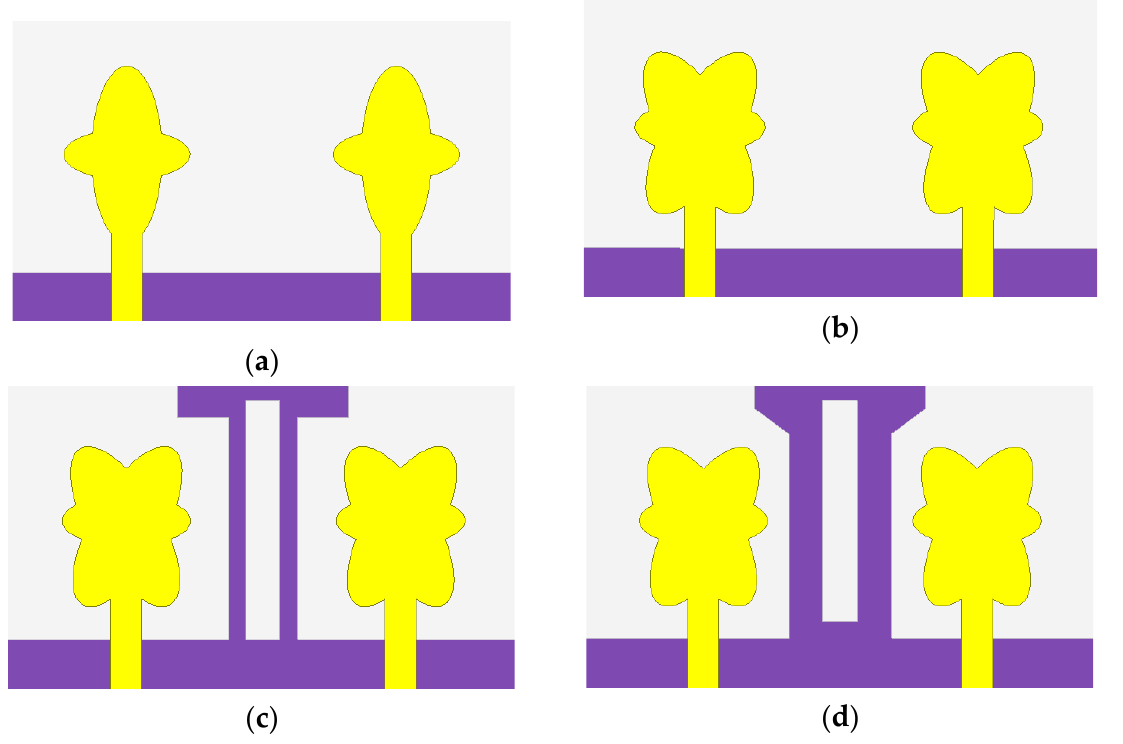
Figure 3. Evolution of the design process of UWB-MIMO system: ( a ) step 1, ( b ) step 2, ( c ) step 3, ( d ) step 4 (proposed MIMO system).